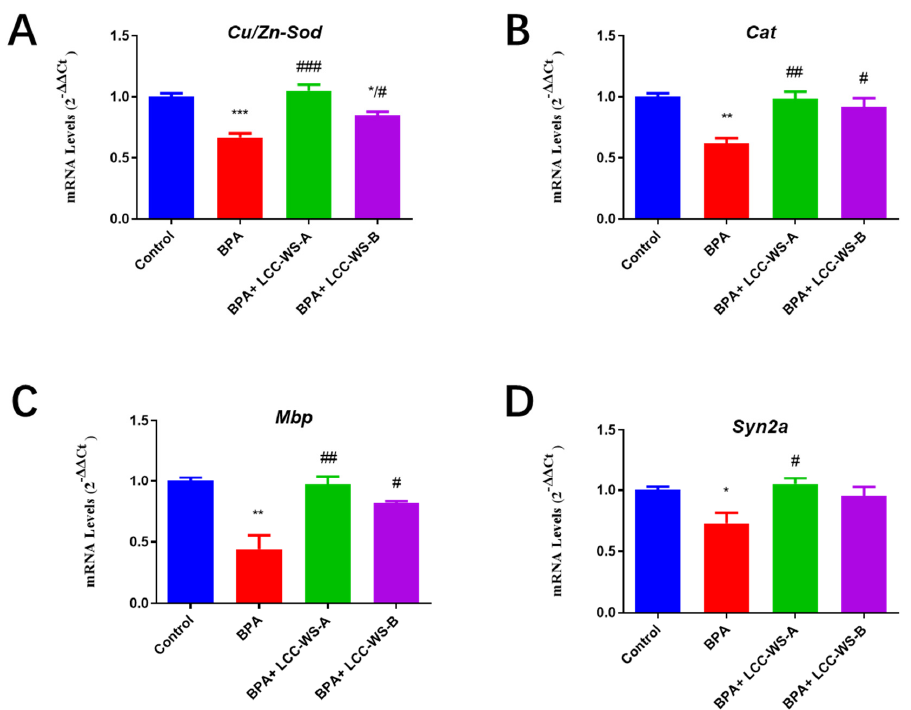
Figure 7. Effects of LCC-WS-A and LCC-WS-B on the expression of oxidative stress- and neurogenesis-related genes in BPA-treated zebrafish. Cu/Zn-Sod ( A ), cat ( B ), mbp ( C ) and syn2a ( D ). * p < 0.05, ** p < 0.01, *** p < 0.001, compared with control groups. # p < 0.05, ## p < 0.01, ### p < 0.001, compared with the BPA-treated group.